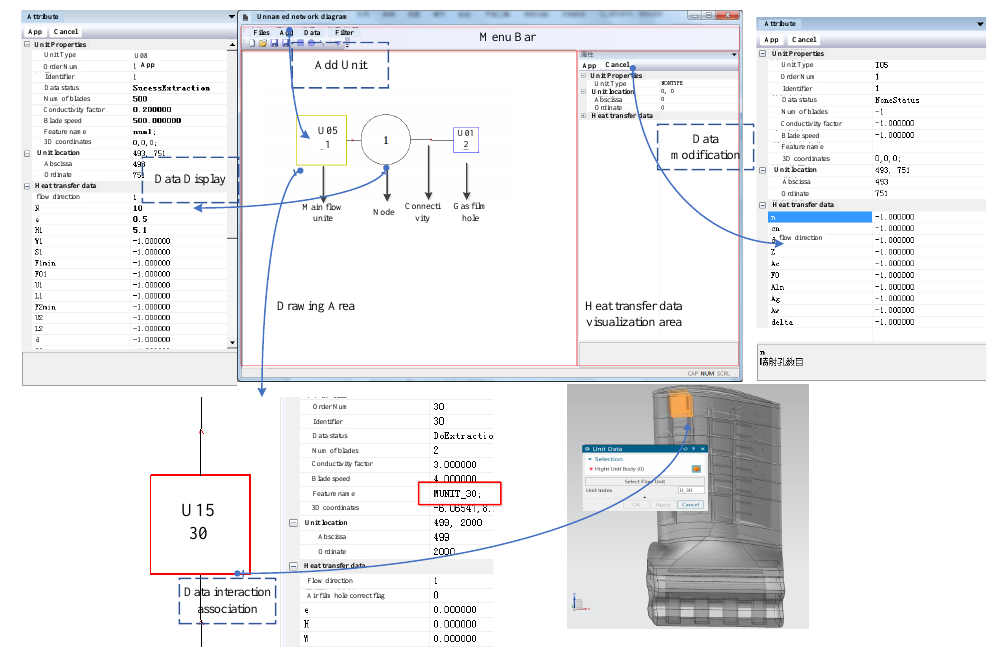
Figure 33. Network diagram visualization and data